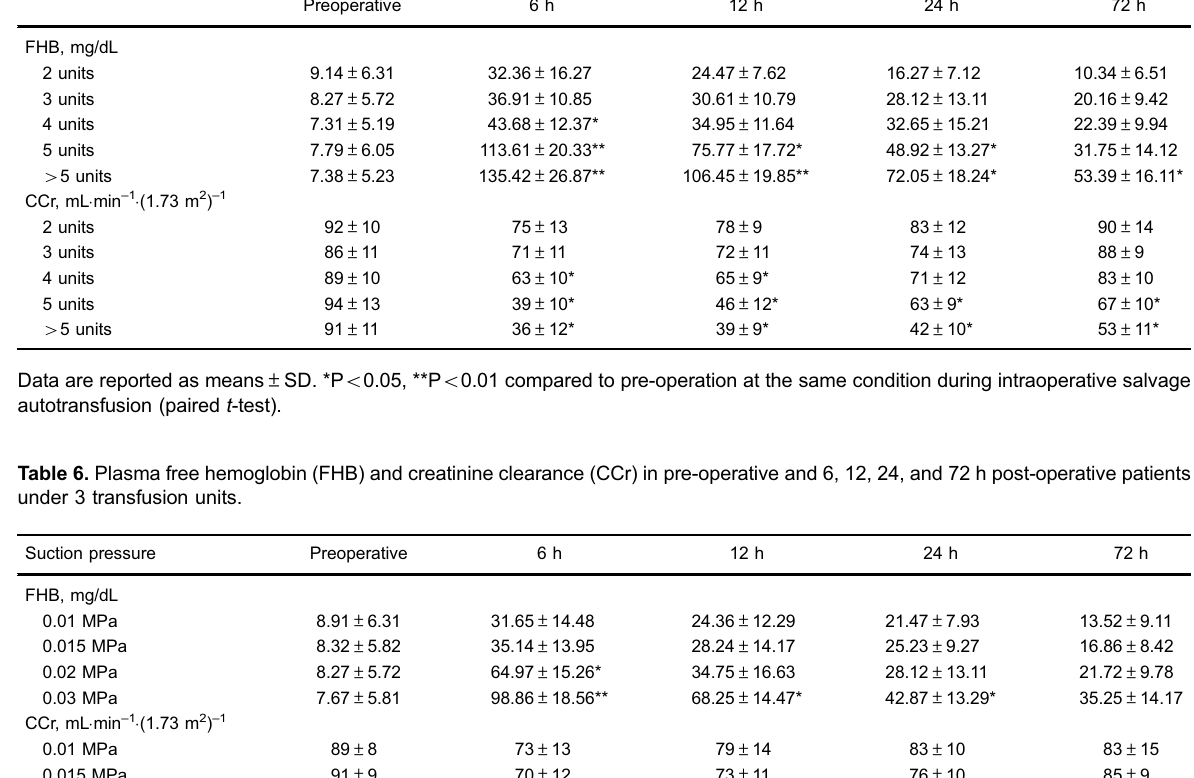
Table 5. Plasma free hemoglobin (FHB) and creatinine clearance (CCr) in pre-operative and 6, 12, 24, and 72 h post-operative patients under 0.02 Mpa pressure.